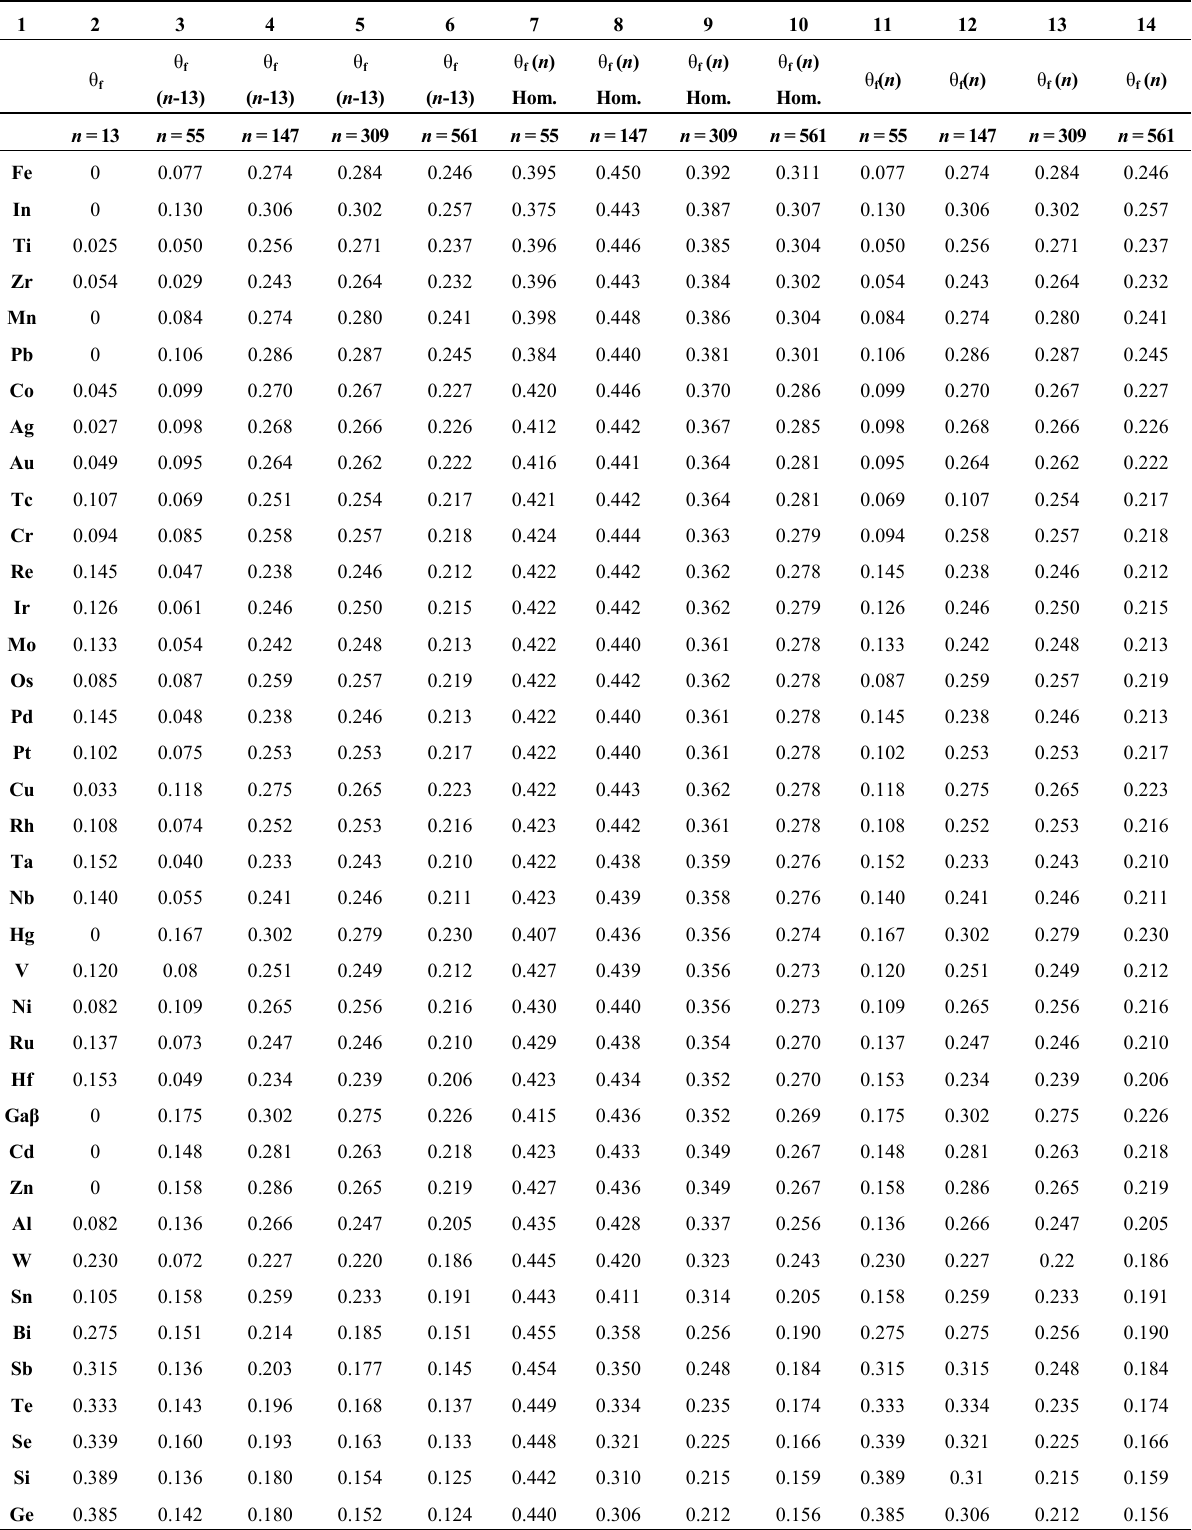
Table 3. The melting temperatures of superclusters. The final melting temperatures are given in Columns 2, 11, 12, 13 and 14. The temperatures in Columns 3, 4, 5 and 6 are calculated assuming that the melting starts from 13-atom droplets acting as heterogeneous nuclei in the core of superclusters. Those in Columns 7, 8, 9 and 10 correspond to a liquid homogeneous